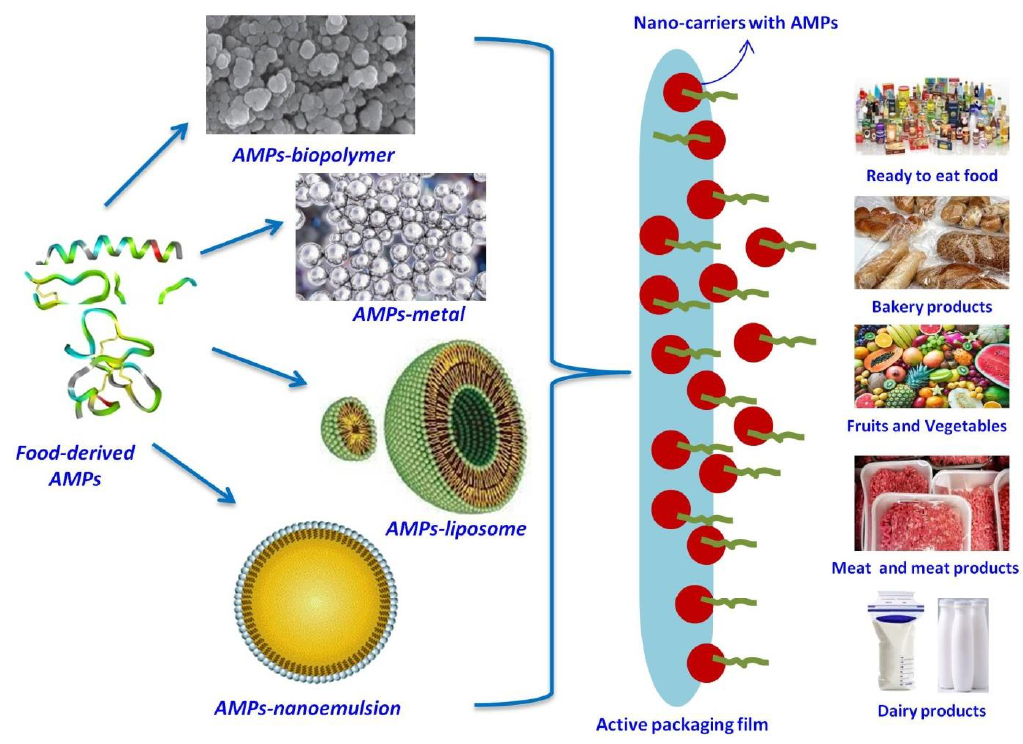
Figure 2. Nano-conjugation of F-AMPs with diverse nanomaterials and potential application in active food packaging of different food products .